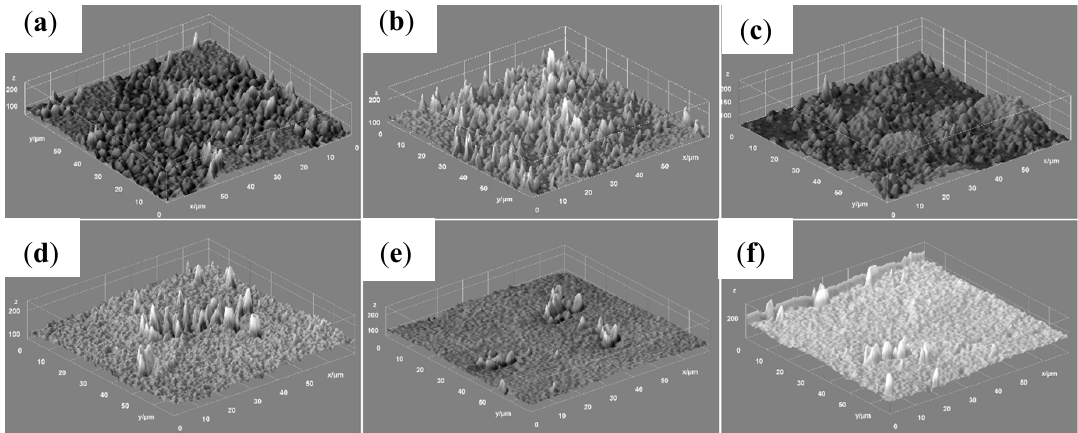
Figure 13. SEM images of Candida albicans ATCC 10231 cell development on HAp ( a – c ) and 5SmHAp coatings ( d – f ) at different time intervals of incubation 24 h ( a , d ) 48 h ( b , e ) and 72 h ( c , f ).